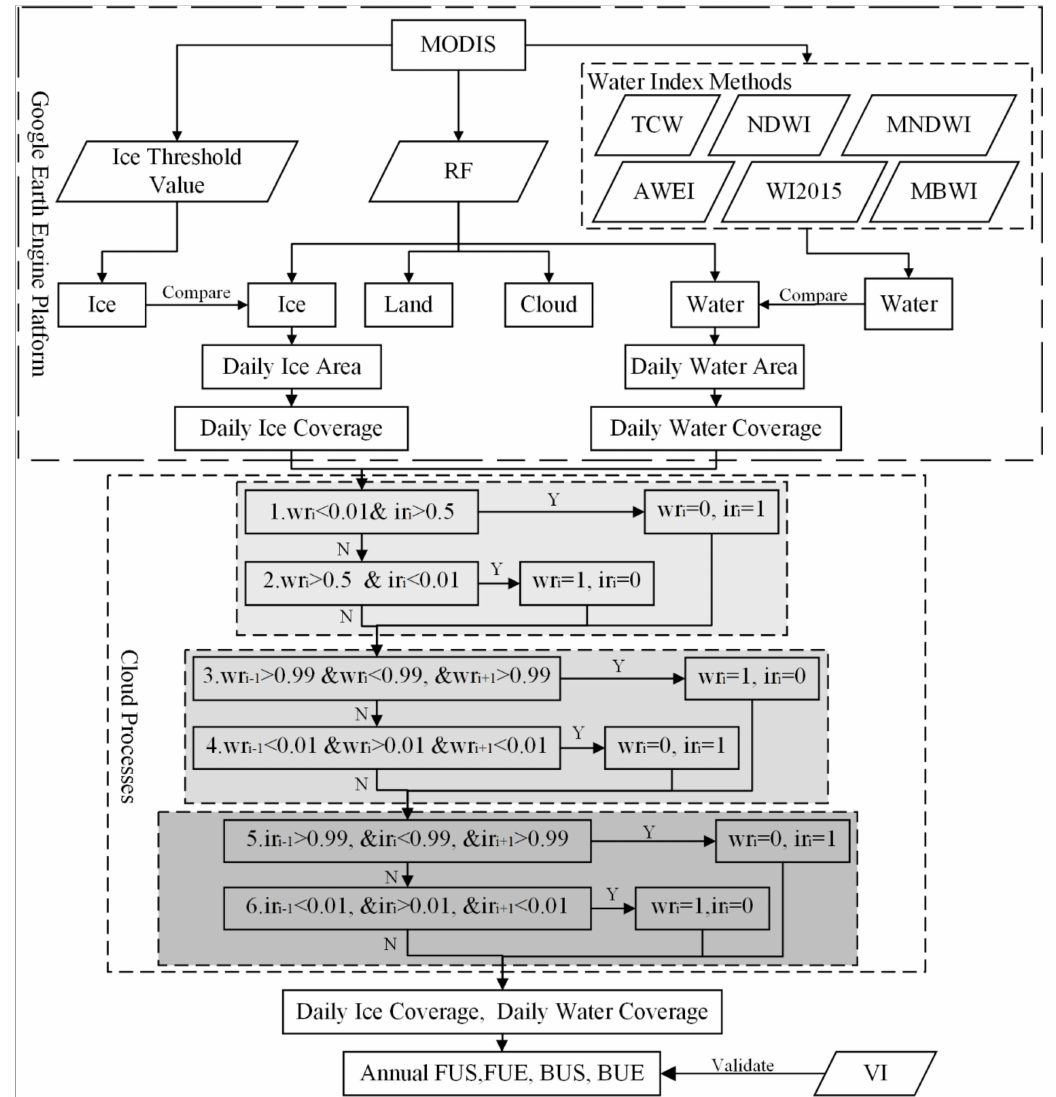
Figure 2. Processing flowchart of MODIS data based on the GEE platform (ice is derived from Ice Threshold Value, and water is derived from six common water index methods. The results are compared with ice and water derived from RF. The daily ice coverage and water coverage derived from RF